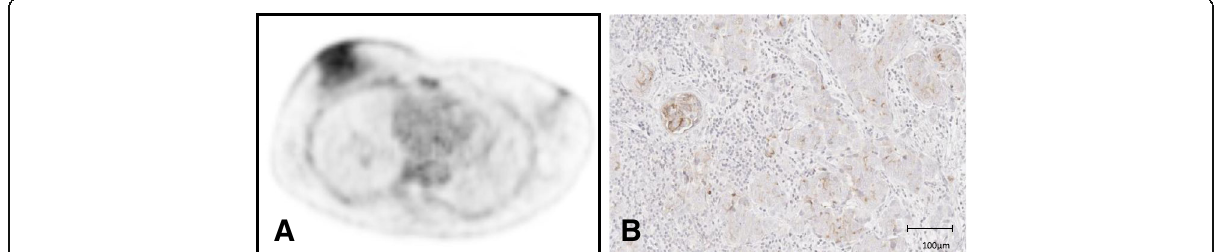
Fig. 3 Example of a patient with primary breast cancer exhibiting moderate tracer uptake of the primary tumor on 68 Ga-Pentixafor PET ( a ) and corresponding moderate CXCR4 expression on immunohistochemistry ( b